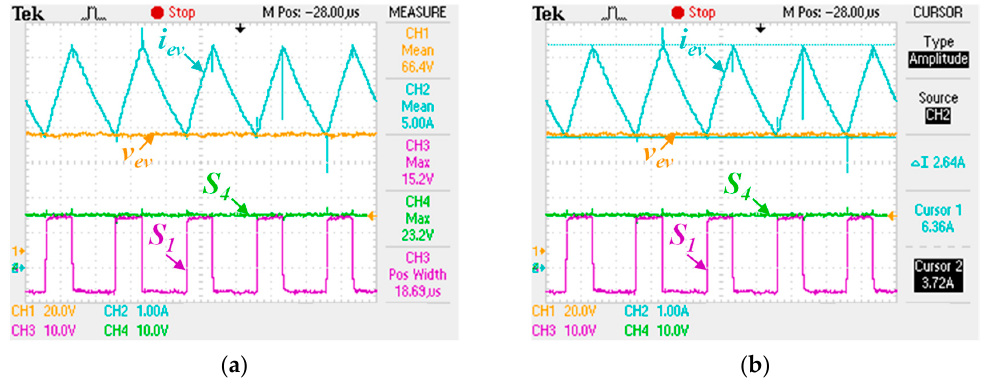
Figure 19. Steady-state operation of the multilevel dc–dc converter following a failure in the neutral wire of the bipolar dc grid: ( a ) an i ev of 5 A and a v ev of 66.4 V; ( b ) an i ev ripple value of 2.64 A and a duty cycle of 37% for S 1 , while that of S 4 is equal to 100%.